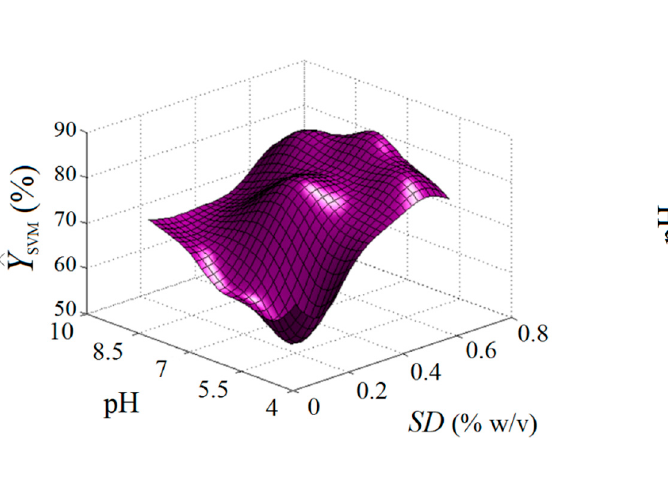
^ (cid:3020)(cid:3023)(cid:3014) ) .